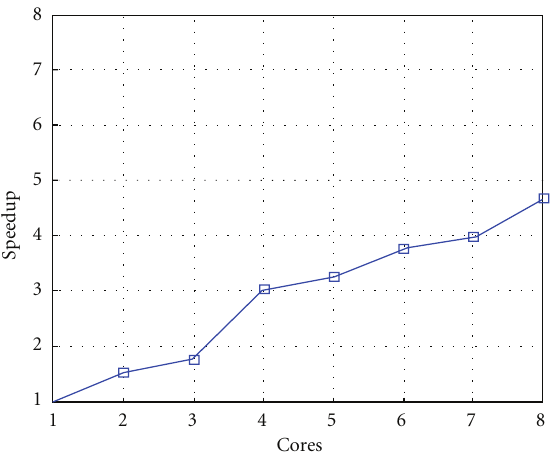
Figure 24: Test 2: Algorithm I: Total execution time versus the number of cores. Δ τ I = 0 . 4.